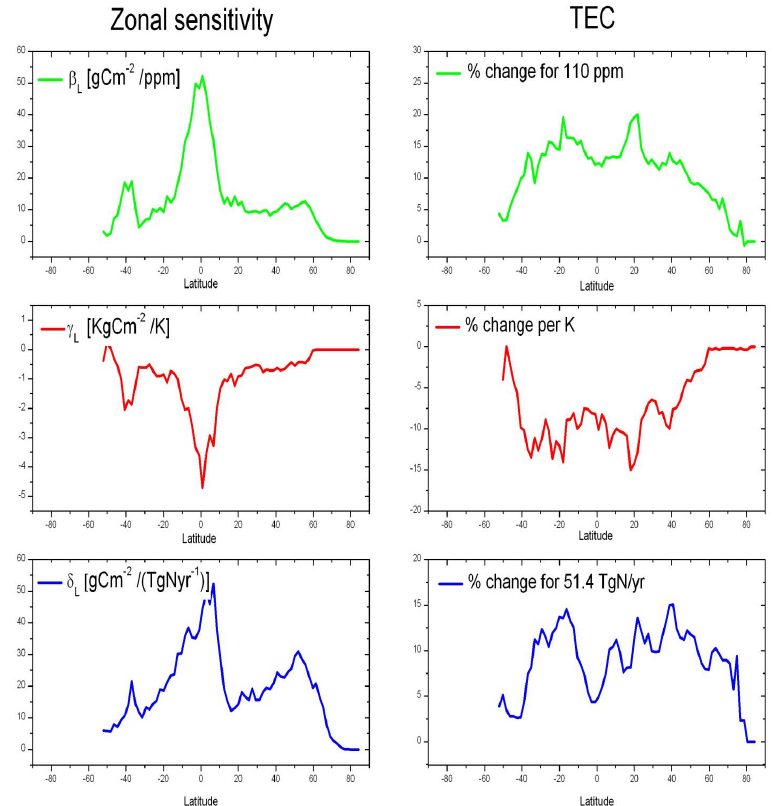
Fig. 9. Zonal mean pattern total ecosystem carbon (TEC) sensitivity for CO 2 change ( β L ) , climate change ( γ L ) and N deposition ( δ L ; left panels). The right panels show the percentage changes in TEC during the historical period due to CO 2 change (110ppm), climate warming ( ∼ 1K) and N deposition (51.4TgNyr − 1